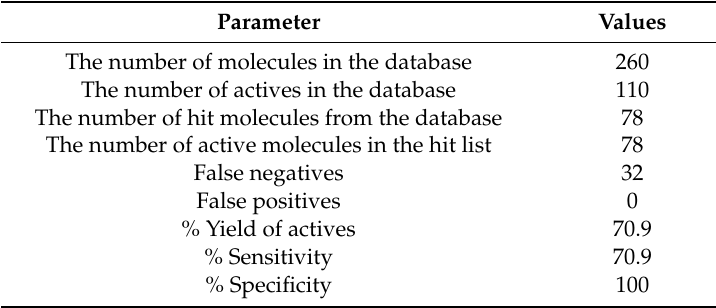
Table 4. Results of the decoy set.